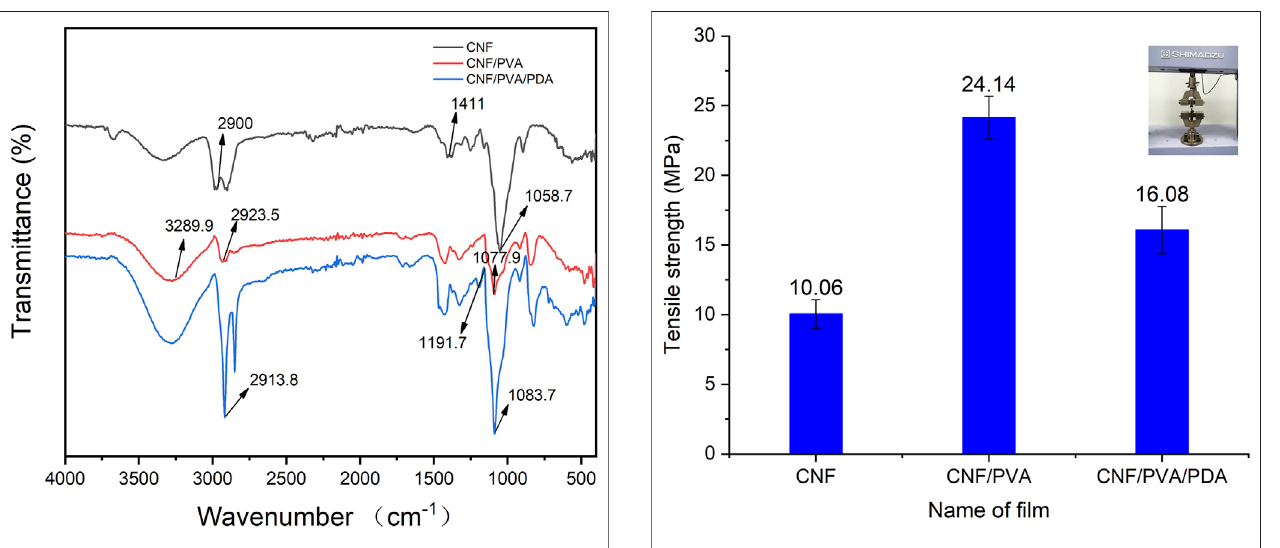
FIGURE 6 | FTIR of CNF, CNF/PVA, CNF/PVA/PDA fi lms. FIGURE7| ThetensilestrengthofCNF,CNF/PVA,CNF/PVA/PDA